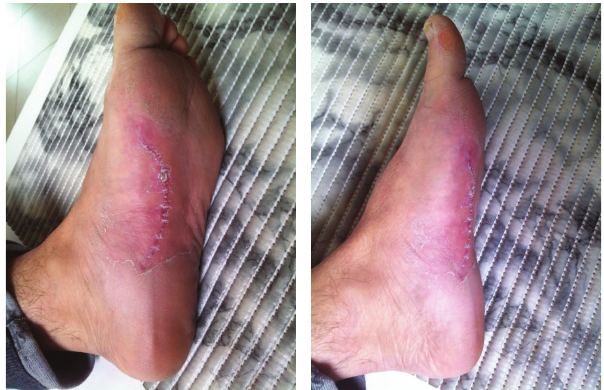
Figure 11: Normotrophic scar at 2-month follow-up.